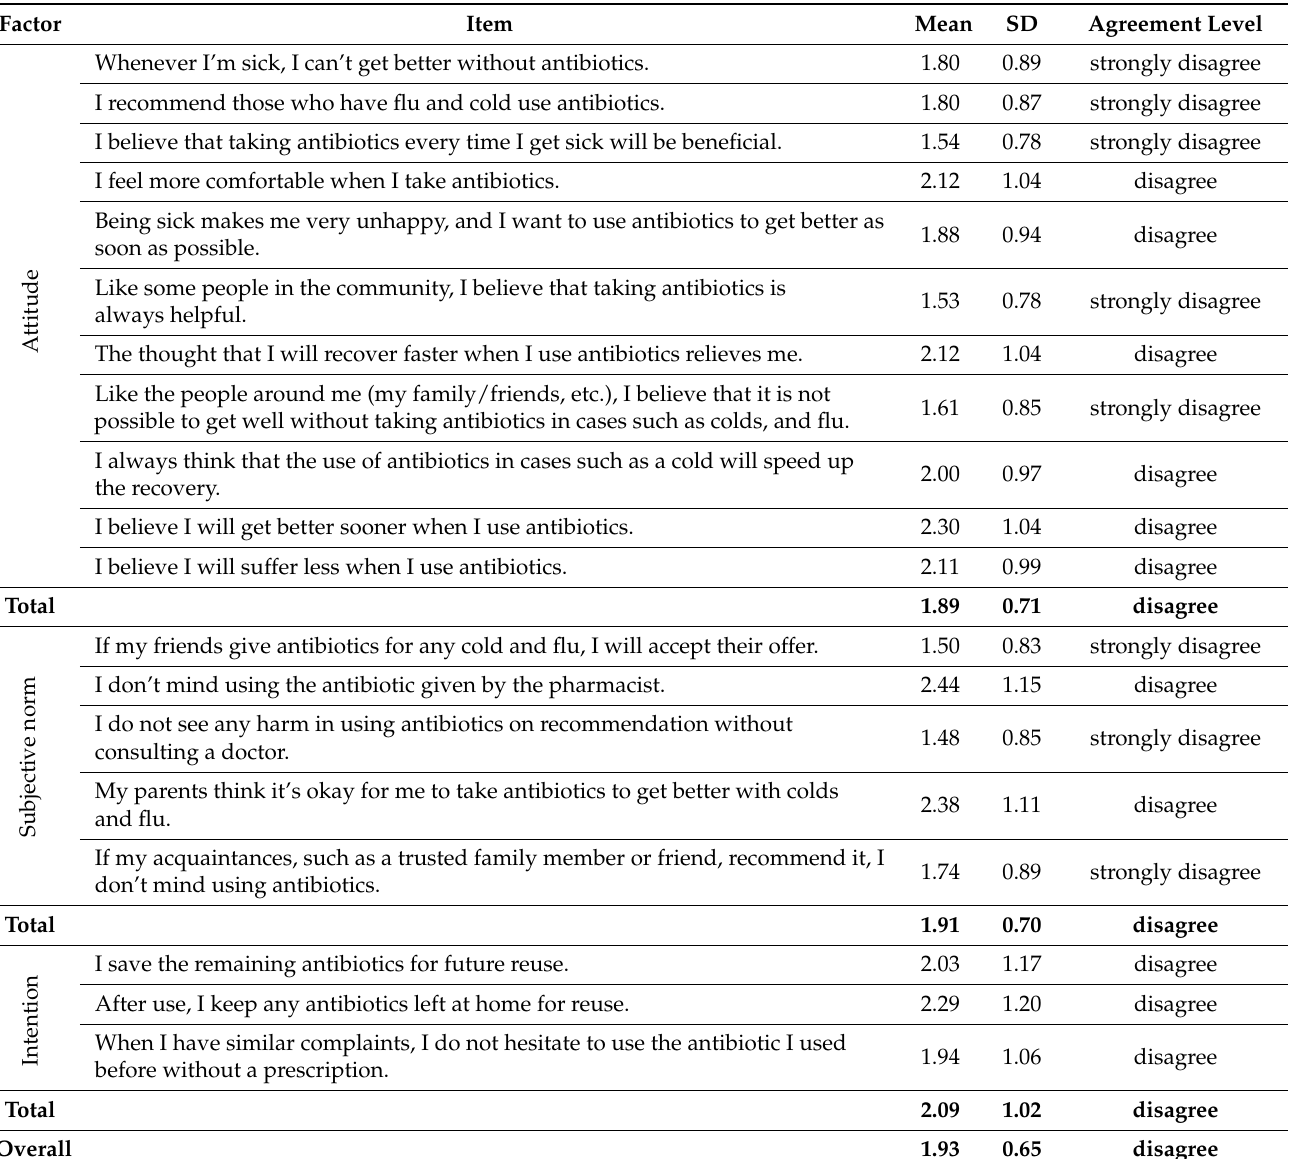
Table 2. AUS scores related to the participants’ opinions towards antibiotic